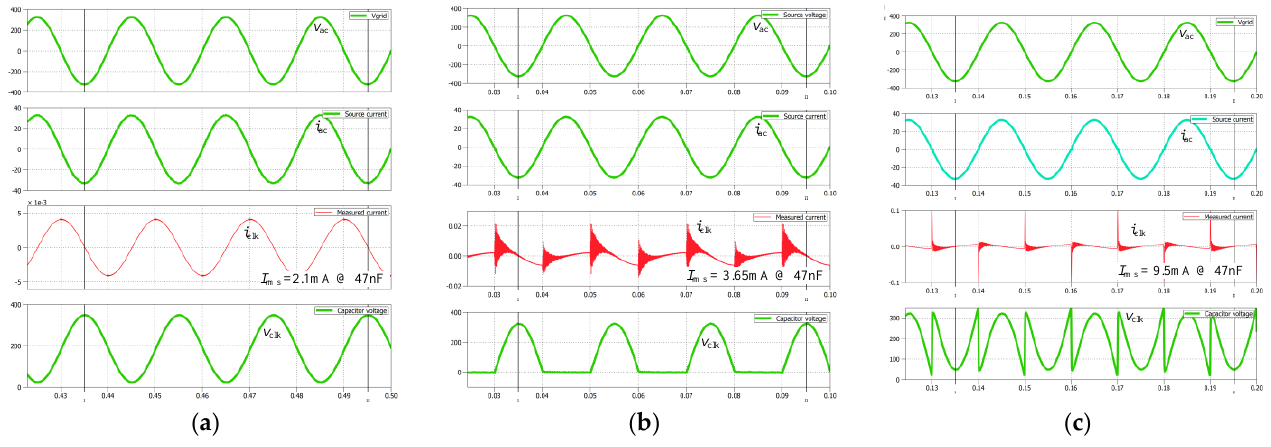
Figure 9. Simulation results of the prior PFCs in [18,26] and the PFC in this paper. ( a ) Conventional full-bridge PFC with bipolar switching scheme in [18], ( b ) conventional full-bridge PFC with AVG in [26], and ( c ) PFC in this paper.